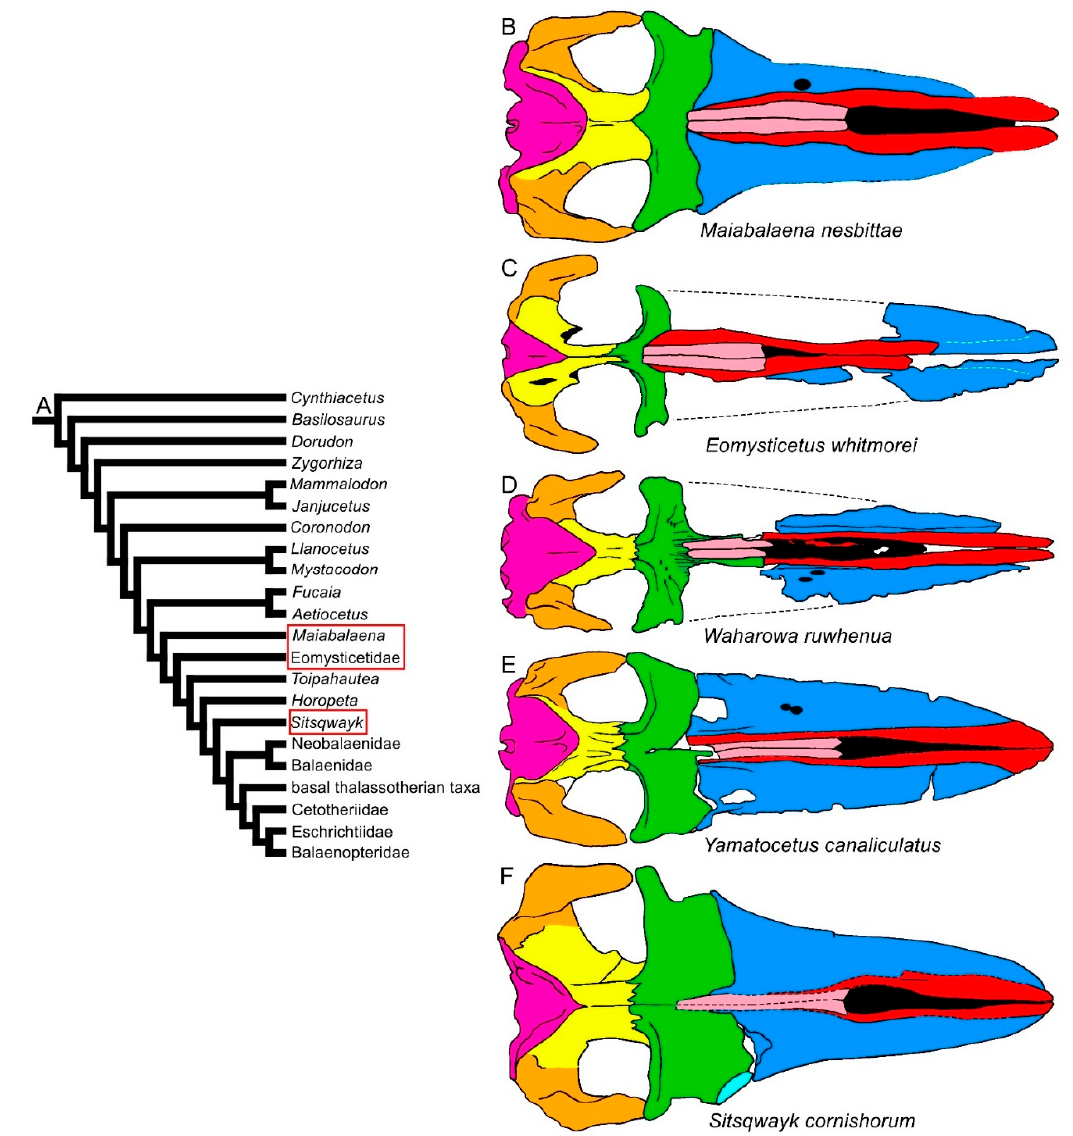
Figure 10. Diversity of mysticete skulls in dorsal view: stem- and early Chaeomysticeti. ( A ) Phylogenetic relationships among mysticetes showing the branching order of Maiabalaena , Eomysticetidae and Sitsqwayk (red ellipses). ( B ) Skull of Maiabalaena nesbittae . ( C ) Skull of Eomysticetus whitmorei . ( D ) Skull of Waharowa ruwhenua . ( E ) Skull of Yamatocetus canaliculatus . ( F ) Skull of Sitsqwayk cornishorum . Not to scale. The skulls are represented as if they shared the same condylobasal length.